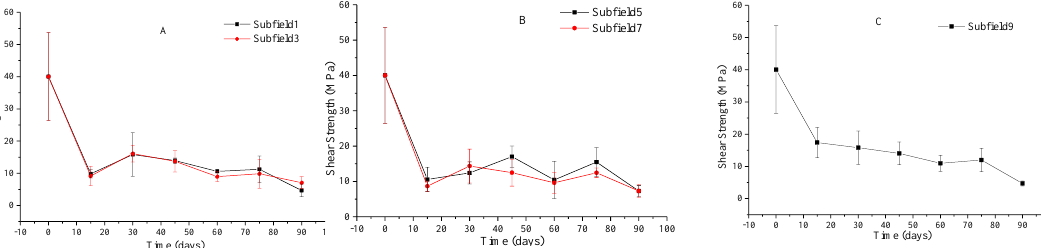
Figure 8. Changes in the shear strength over time with different tillages. Note: ( A )—Plowing; ( B )—Dry rotary; ( C )—Wet Rotary.